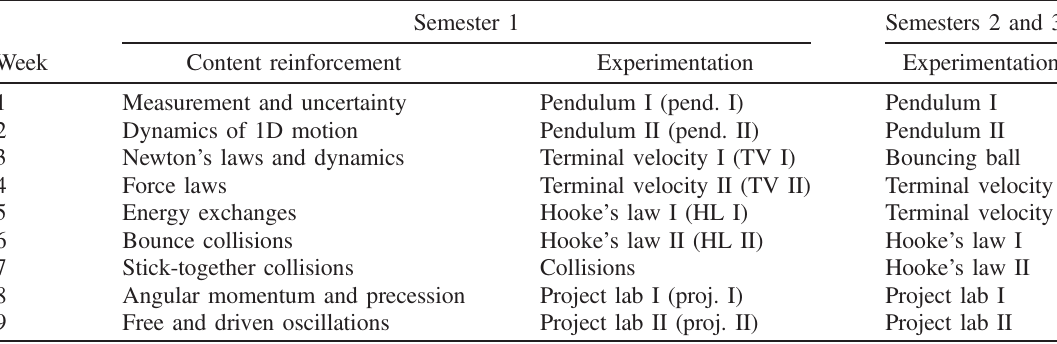
TABLE I. Order of lab activities for each lab condition. We use abbreviations for lab activities (in parentheses) later in the paper to avoid confusion about the differences in weeks between experimentation labs in semesters 1, 2, and